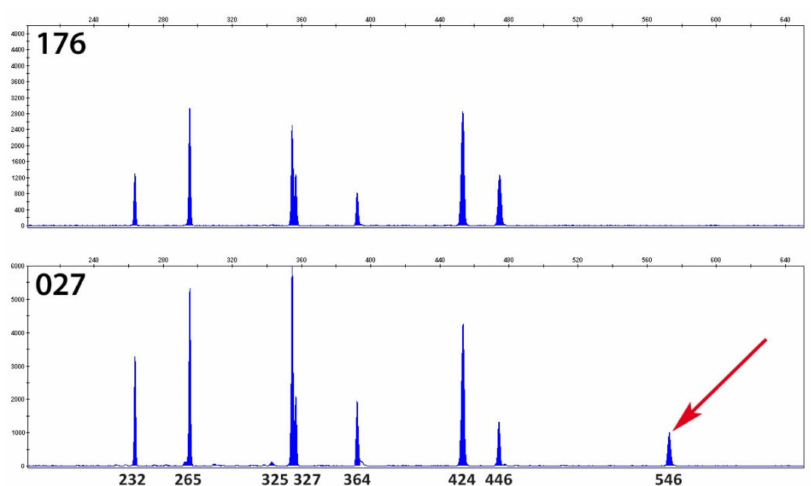
Figure 2. The capillary electrophoresis PCR ribotyping patterns of ribotype 027 and 176. Fragment analysis was performed on an ABI 3130xl DNA analyzer (Applied Biosystems) with the LIZ 1200 size standard (Applied Biosystems). The electrophoreograms were visualized in Gene Mapper v5.0 (Applied Biosystems). The numbers indicate the length of individual fragments in bases.